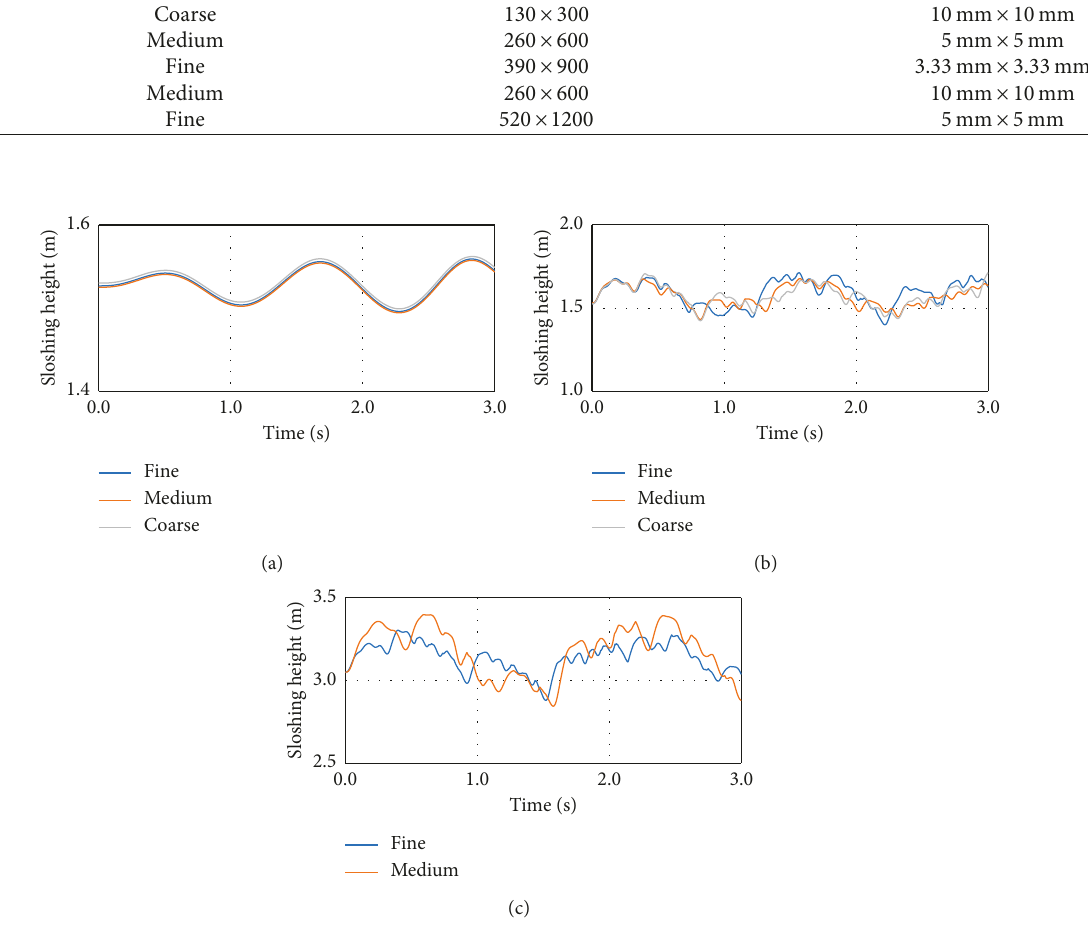
Figure 3: Comparison of sloshing for the sensitivity study. Sloshing heights in (a) 1/8 models under 1 Hz, (b) 1/8 models under 10Hz, and (c) 1/4 models under